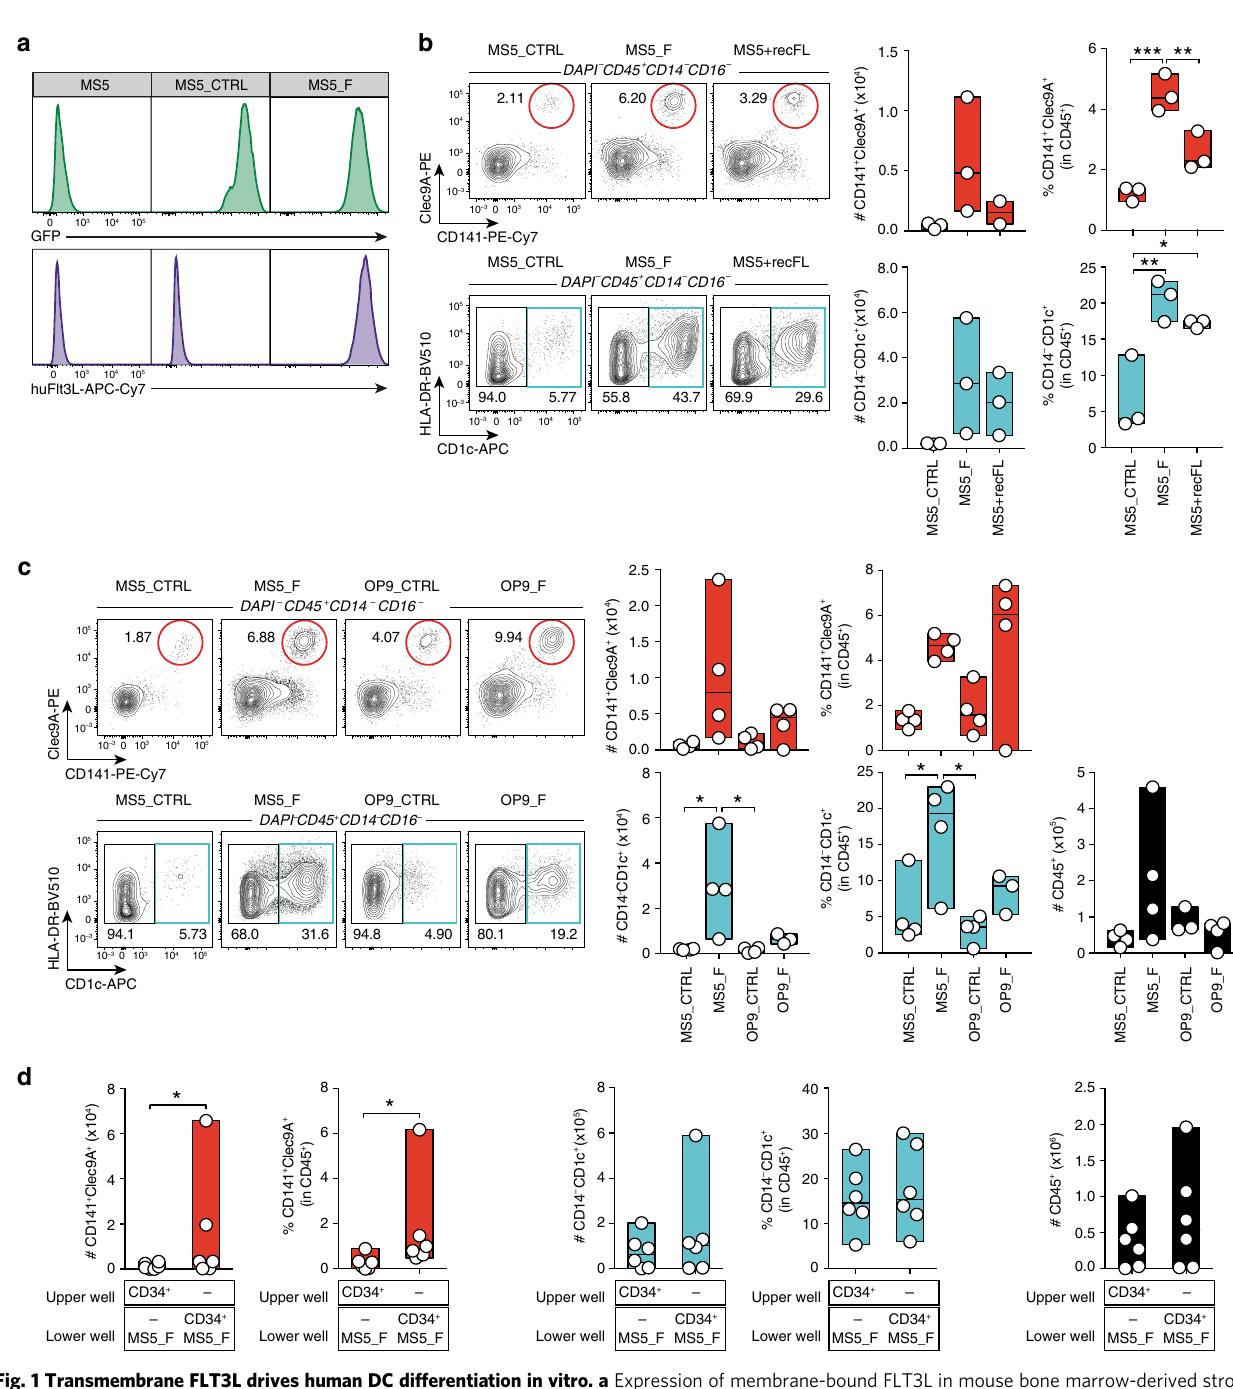
Fig. 1 Transmembrane FLT3L drives human DC differentiation in vitro. a Expression of membrane-bound FLT3L in mouse bone marrow-derived stromal cells engineered to express human FLT3L (MS5_F) and control (MS5_CTRL). b Human cDC subsets differentiated in vitro from CD34 + cord blood-derived HSPCs cultured with MS5 expressing membrane-bound FLT3L (MS5_F) or MS5 supplemented with recombinant human FLT3L (MS5 + recFL) at day 15 ( n = 3 donors in one experiment). * p < 0.05, ** p < 0.01, *** p < 0.001, one-way ANOVA test with Tukey ’ s multiple comparisons. c Representative fl ow cytometry plots and quanti fi cation of human cDC subsets differentiated in vitro from cord blood-derived CD34 + progenitors in culture with mouse stromal cell lines MS5 and OP9 expressing human FLT3L (MS5_F and OP9_F) at day 15 ( n = 4 donors in one experiment). * p < 0.05, one-way ANOVA test with Tukey ’ s multiple comparisons). d Absolute number and frequency of CD141 + Clec9A + and CD14 − CD1c + human cDCs differentiated from CD34 + HSPCs in direct contact (lower well) or physically separated (upper well) from engineered MS5_F. DC differentiation was assessed at day 15 by fl ow cytometry ( n = 6 donors in three independent experiments). * p < 0.05, two-tailed paired Student ’ s t -test. Data are presented as fl oating bars ranging from min to max and line represents median ( b – d